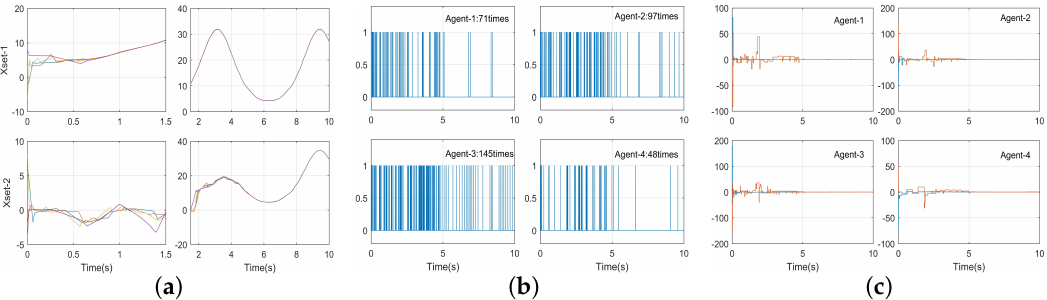
Figure 3. Simulation results of edge-event-triggered control. ( a ) State trajectories of all individuals. ( b ) Update times of all controllers. ( c ) Update values of all controllers.